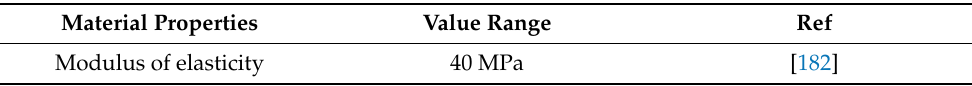
Table 8. Physical and mechanical properties of PGA and its composite material.